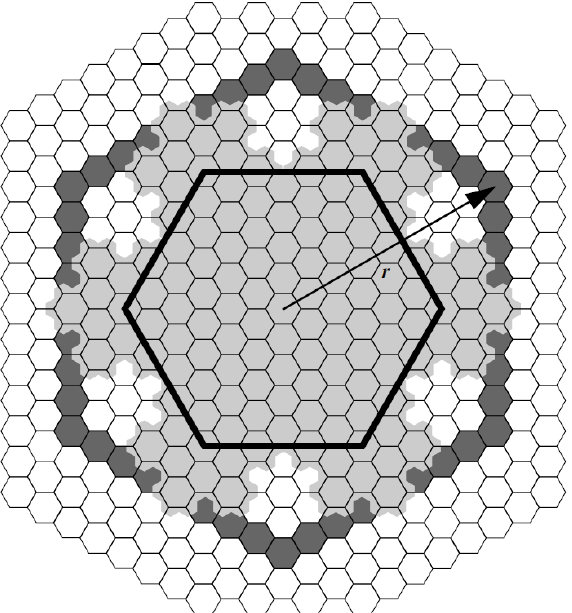
Figure 11. The gray cells are the footprint of the large black hexagon at 4 resolution higher. Image taken Reprinted with permission from Ref. [32] Copyright 2008 Elsevier